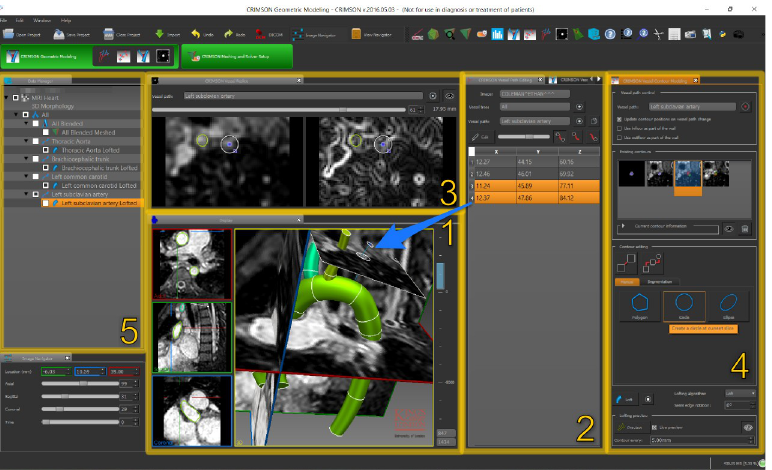
Fig 2. Geometric modelling aspect of the CRIMSON GUI. (1) The image data and segmentation is viewed in three adjustable orthogonal planes and a 3D projection. (2) Centerlines are created for each vessel of interest, editable via coordinates in Panel 2, or 3D interaction in Panel 1 (blue arrow shows relationship). (3) A “re-slice” of the image, consisting of a plane perpendicular to the vessel centerline; this is used to draw two-dimensional contour of the vessels (4). Data objects (centerlines, vessel lofts and trees, etc.) are shown in the data manager